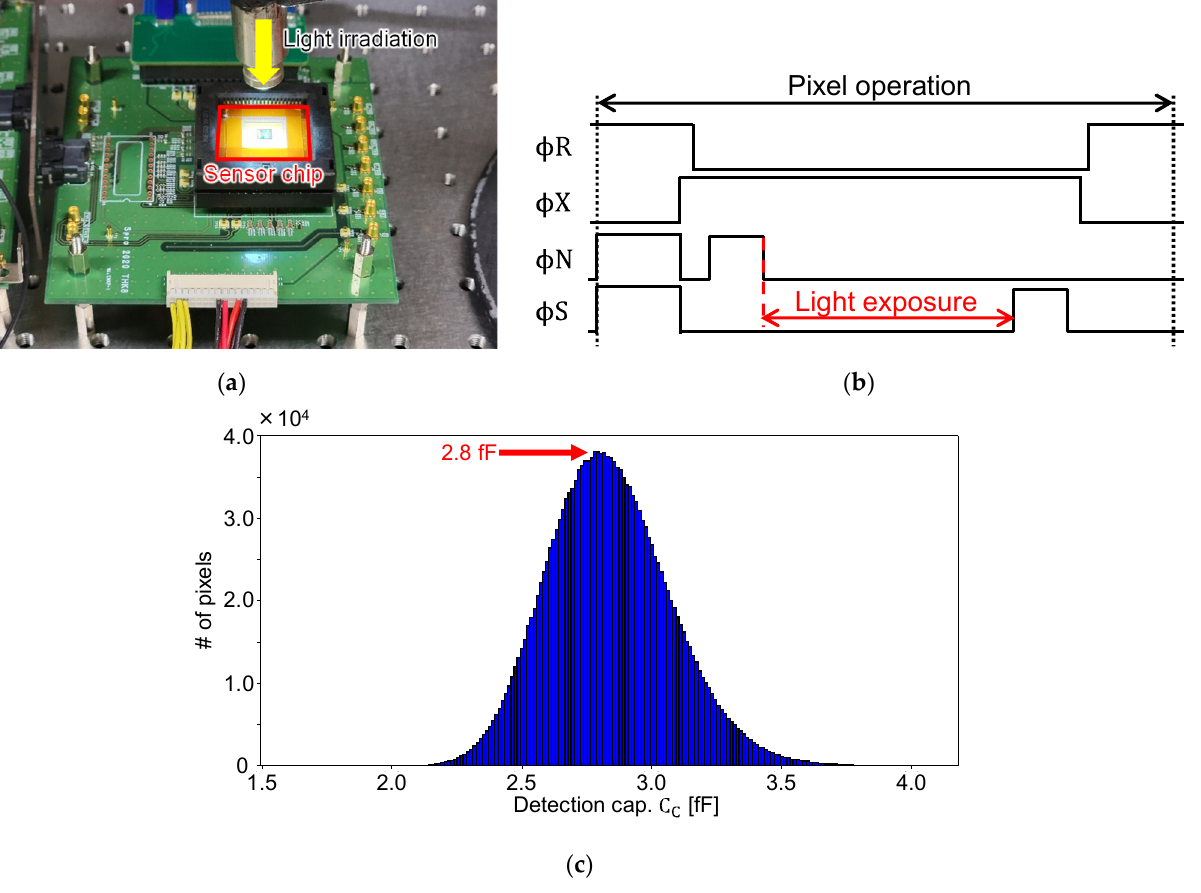
Figure 10. Measurement to determine the capacitance value of C C : ( a ) sensor chip irradiated with light; ( b ) pulse timing; ( c ) histogram of measured C C of Chip B and C C values of the two chips.